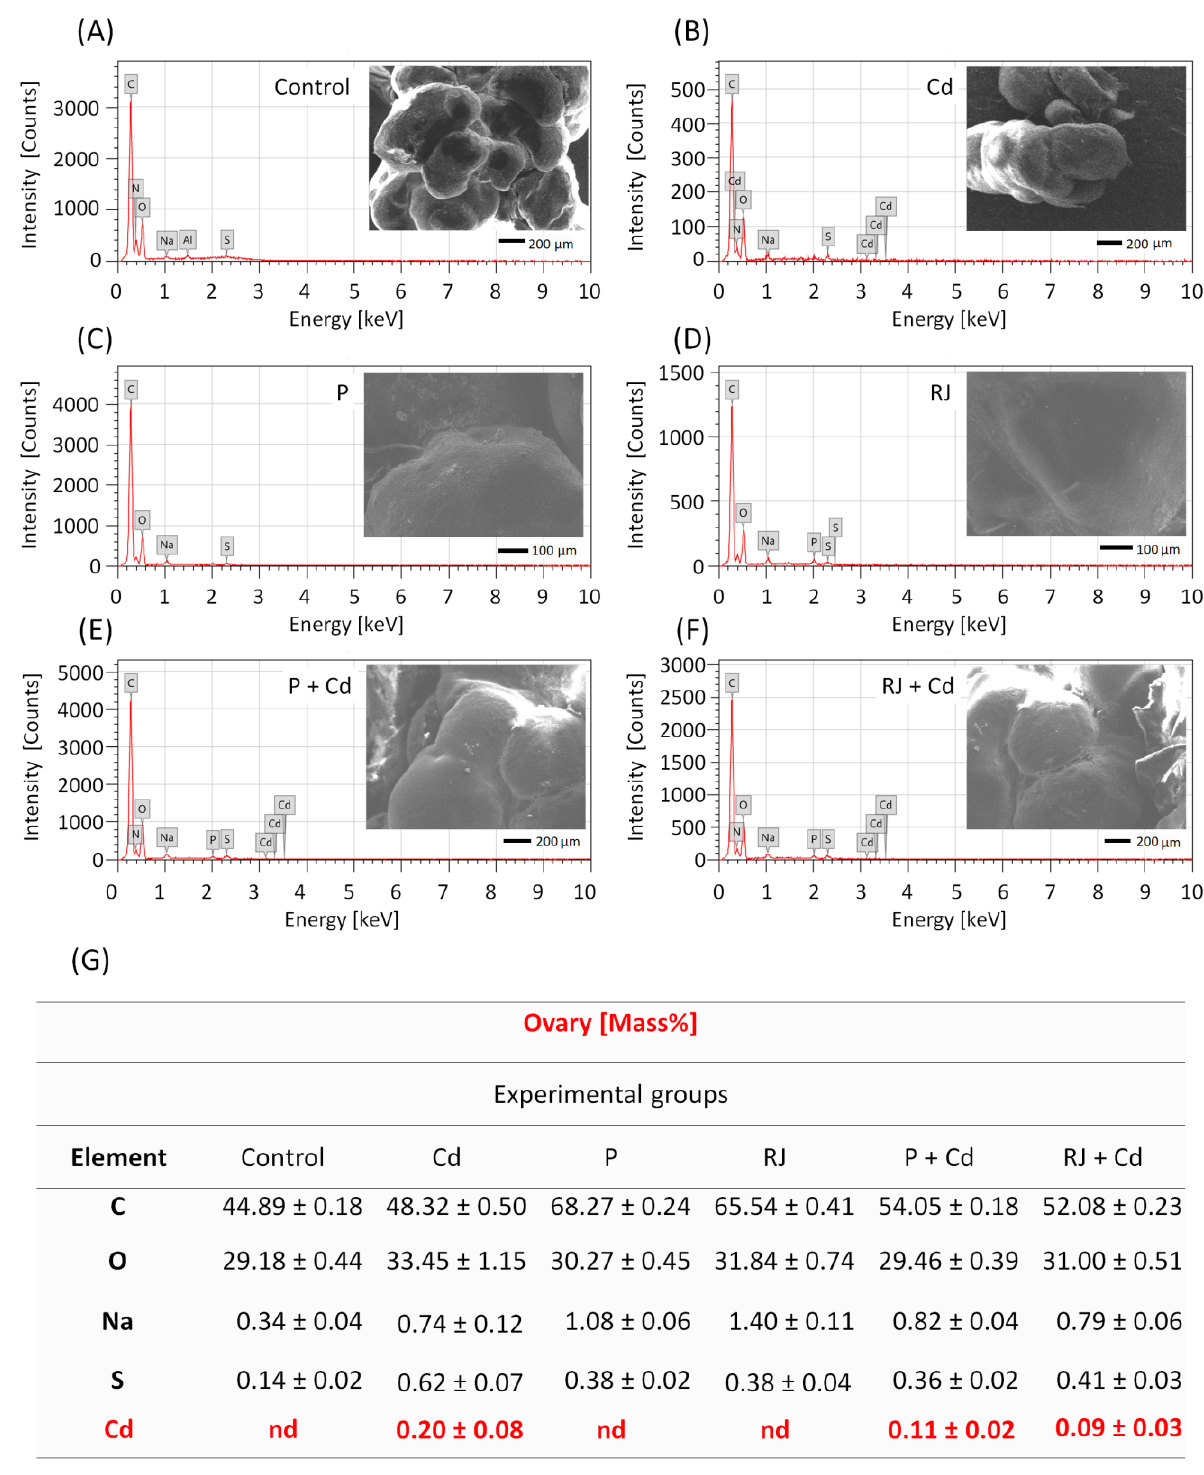
Figure 3. EDX spectra of a selected area of the ovary (SEM of the tissue inserted in the graphs) in the different treated groups: control ( A ), Cd ( B ), P ( C ), RJ ( D ), P + Cd ( E ), and RJ + Cd ( F ), illustrating qualitative elemental composition, and quantitative analysis ( G ). In Figures ( A – E ): horizontal scale — X-ray energy; vertical scale — X-ray counts. C — carbon, Na — sodium, O — oxygen, S — sulfur, Cd — cadmium, nd — not detected.